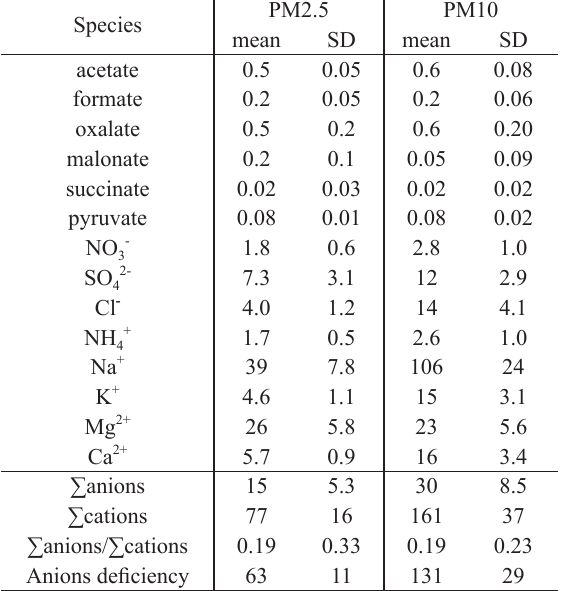
Ion balance (units in neq m -3 ) of samples from